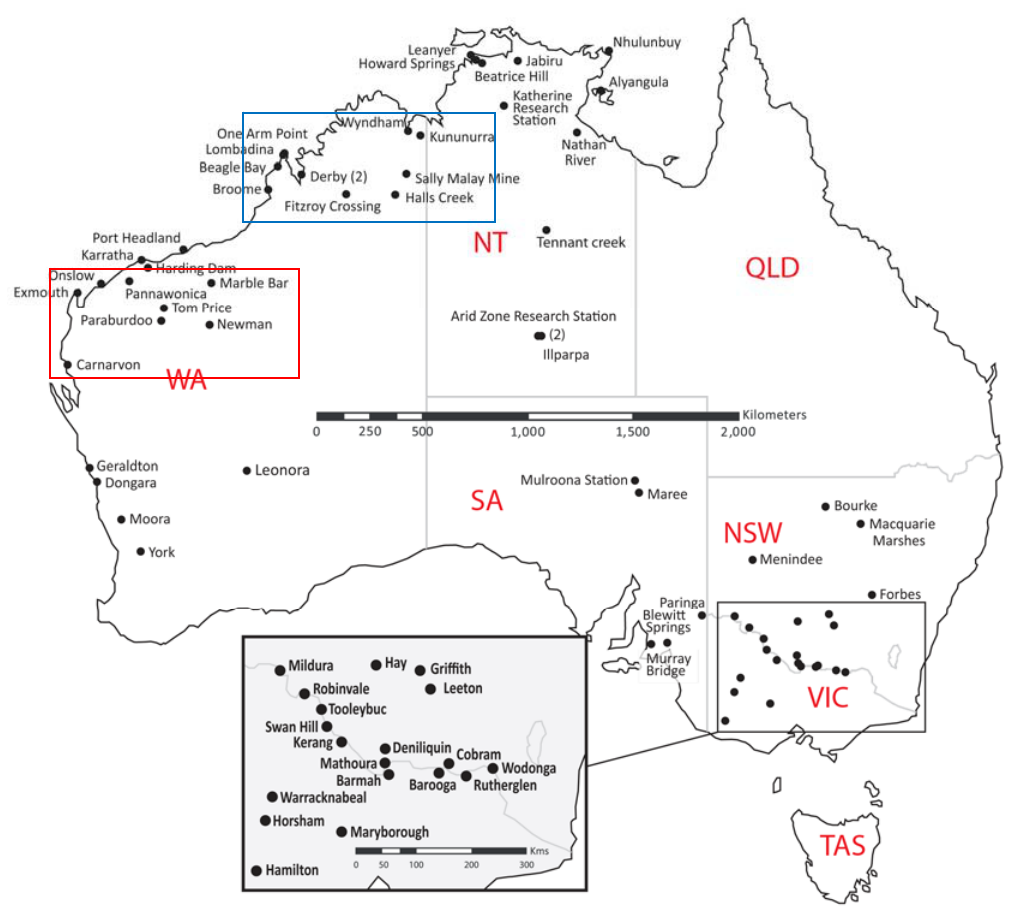
Figure 1. Location of sentinel chicken flocks around Australia, 2010–2011, Adapted from CDI Annual Report Vol. 37 No. 1 2013, used by permission of the Australian Government [26]. Australian states are shown in red. WA—Western Australia, NT— Northern Territory, QLD—Queensland, NSW—New South Wales, VIC—Victoria, TAS— Tasmania. Blue box represents the Kimberley region and the red box the Pilbara region. Inset represents sentinel chicken flocks in Victoria and New South